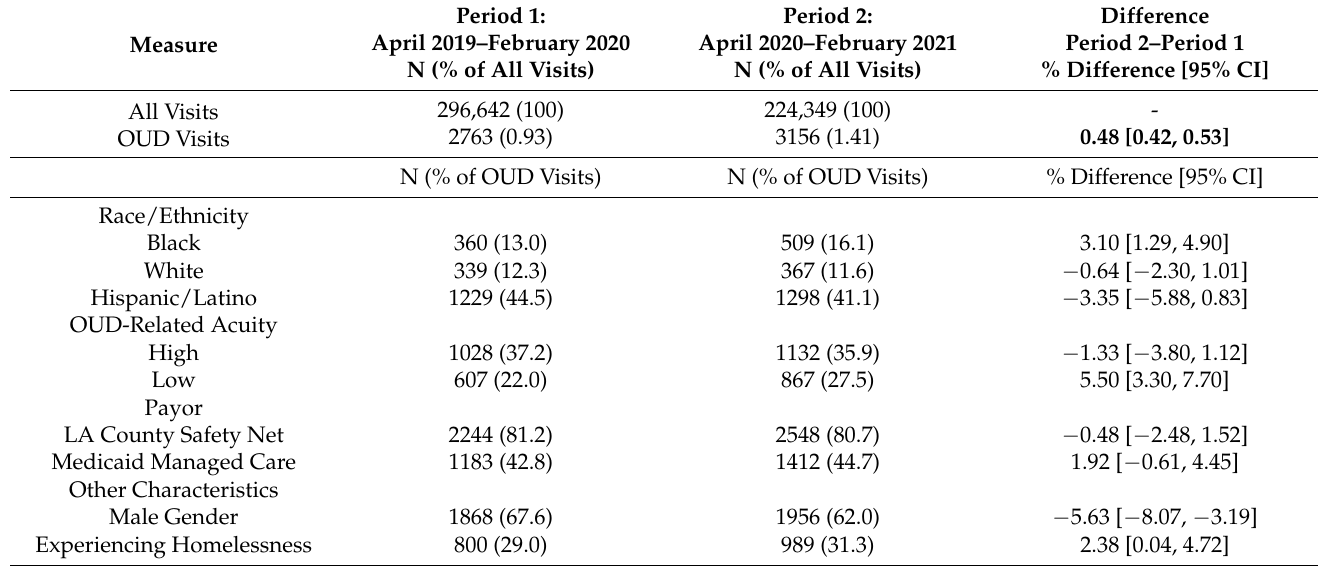
Table 1. Summary Statistics: Demographic and Clinical Characteristics of Opioid-Use-Disorder- Related Emergency Department Patient Encounters Pre- and During COVID-19.